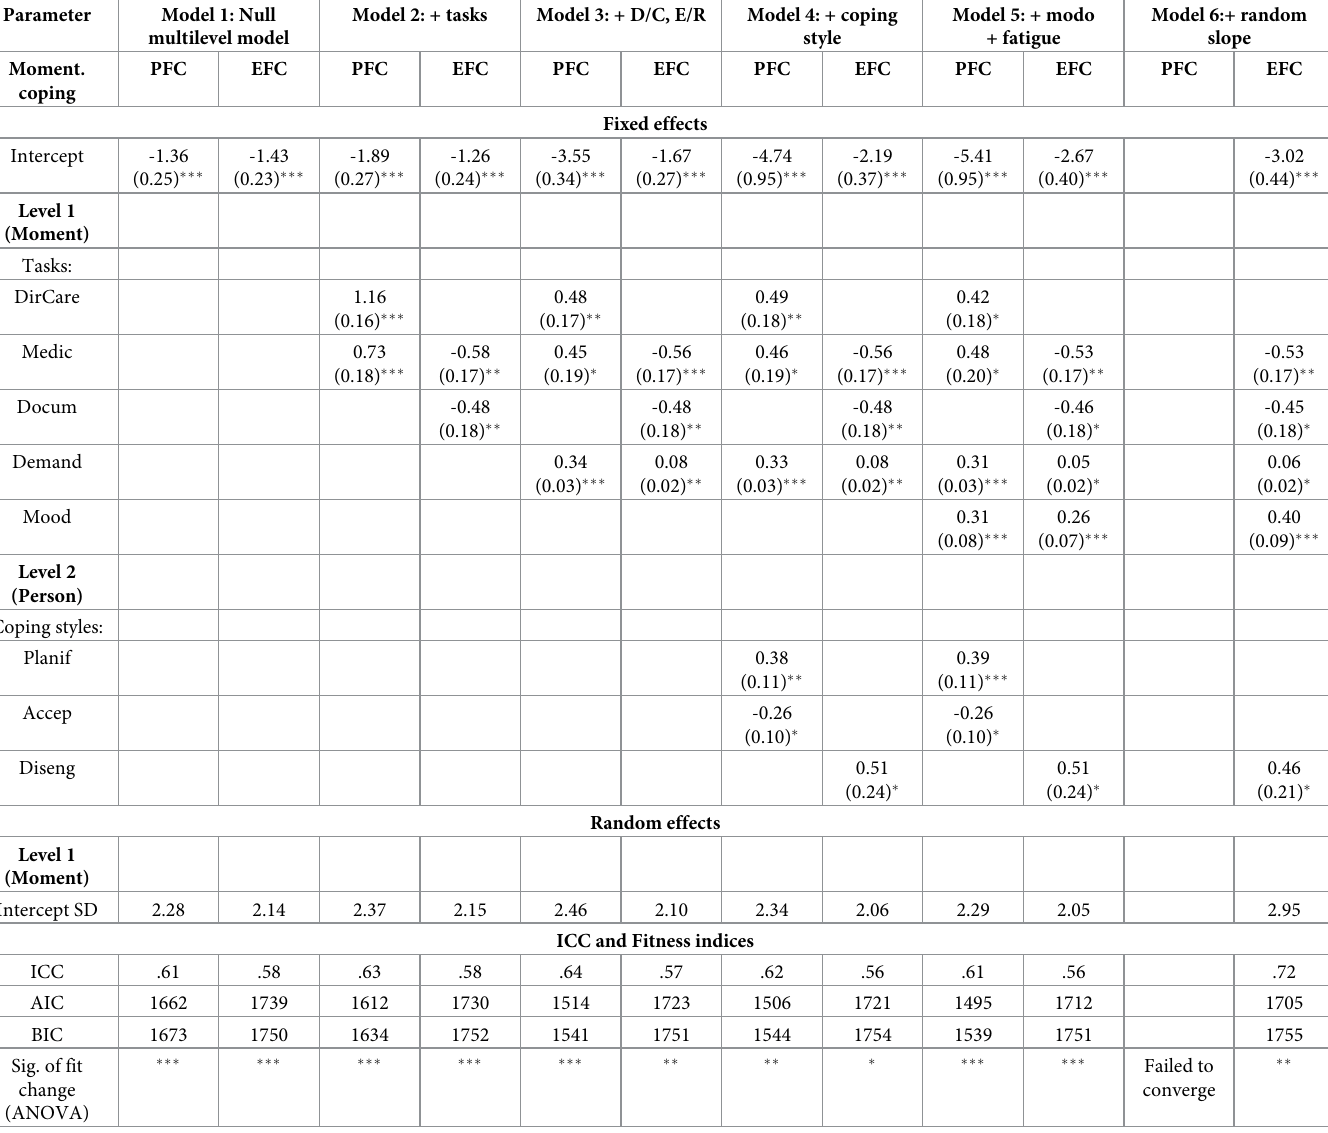
Table 1. Fixed effect (t-test, top) and variance estimates (standard deviation, bottom), and the indices of fitness for models predicting problem-focused (PFC) and emotion-focused approaches to coping